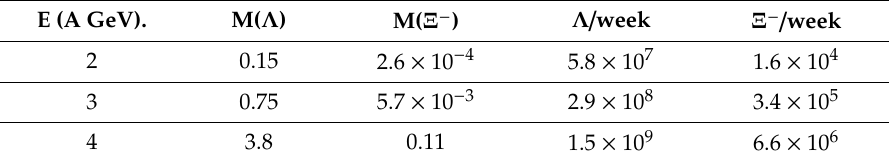
Table 1. Λ and Ξ − multiplicities per central Au + Au collision according to the statistical hadronization model [26], and the yields measured per week taking into account the reconstruction e ffi ciencies (10% for Λ , and 1% for Ξ − ) and the branching ratios (BR = 0.64 for Λ → p + π − and also for Ξ − → Λ + π − → p + π − + π − ). The kinetic beam energies are indicated, the collision rate is 10 kHz. E (A GeV). M( Λ ) M( Ξ − ) Λ / week Ξ − /